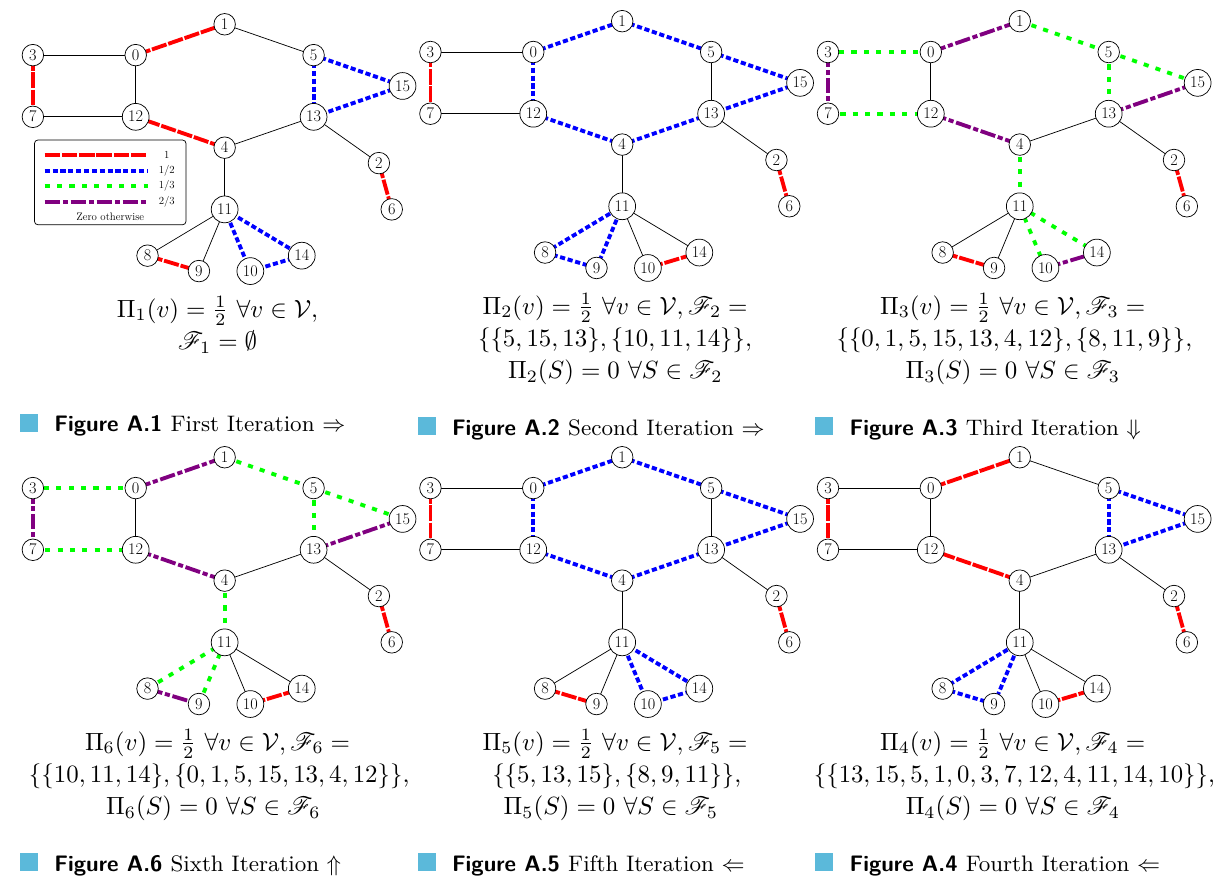
Figure A.6 Sixth Iteration ⇑ Figure A.5 Fifth Iteration ⇐ Figure A.4 Fourth Iteration